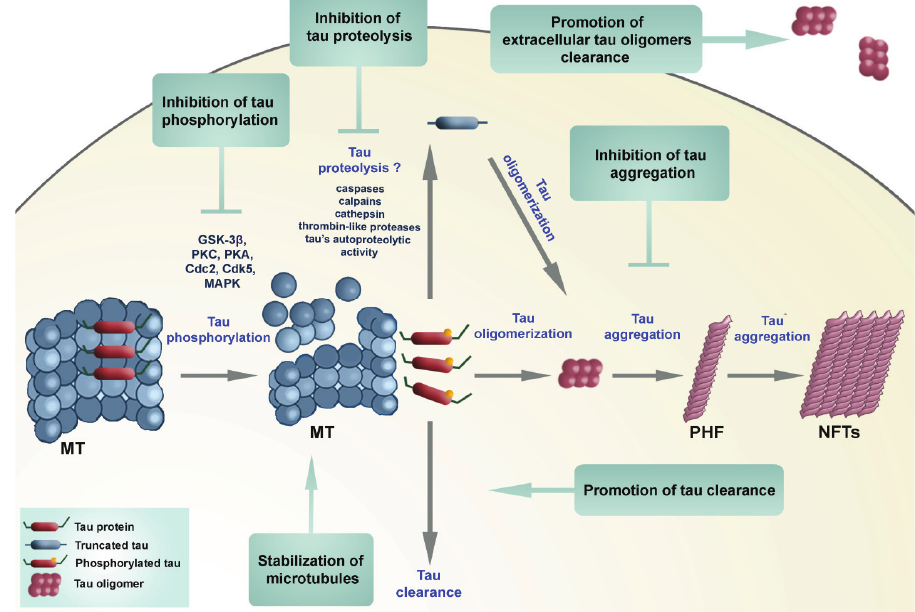
Figure 7. Diagram showing potential neuroprotective strategies to reduce tau aggregates. See text for details.